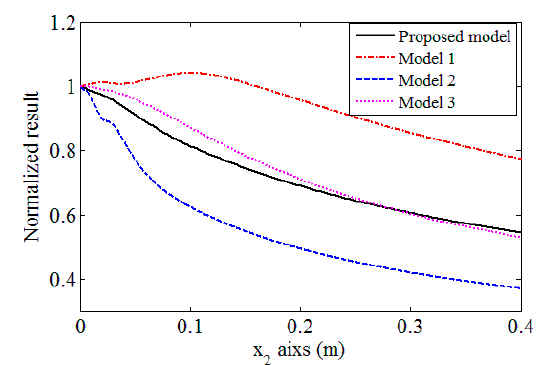
Figure 10. Received results along the propagation distance predicted using different models. Attenuations are neglected in the simulations.